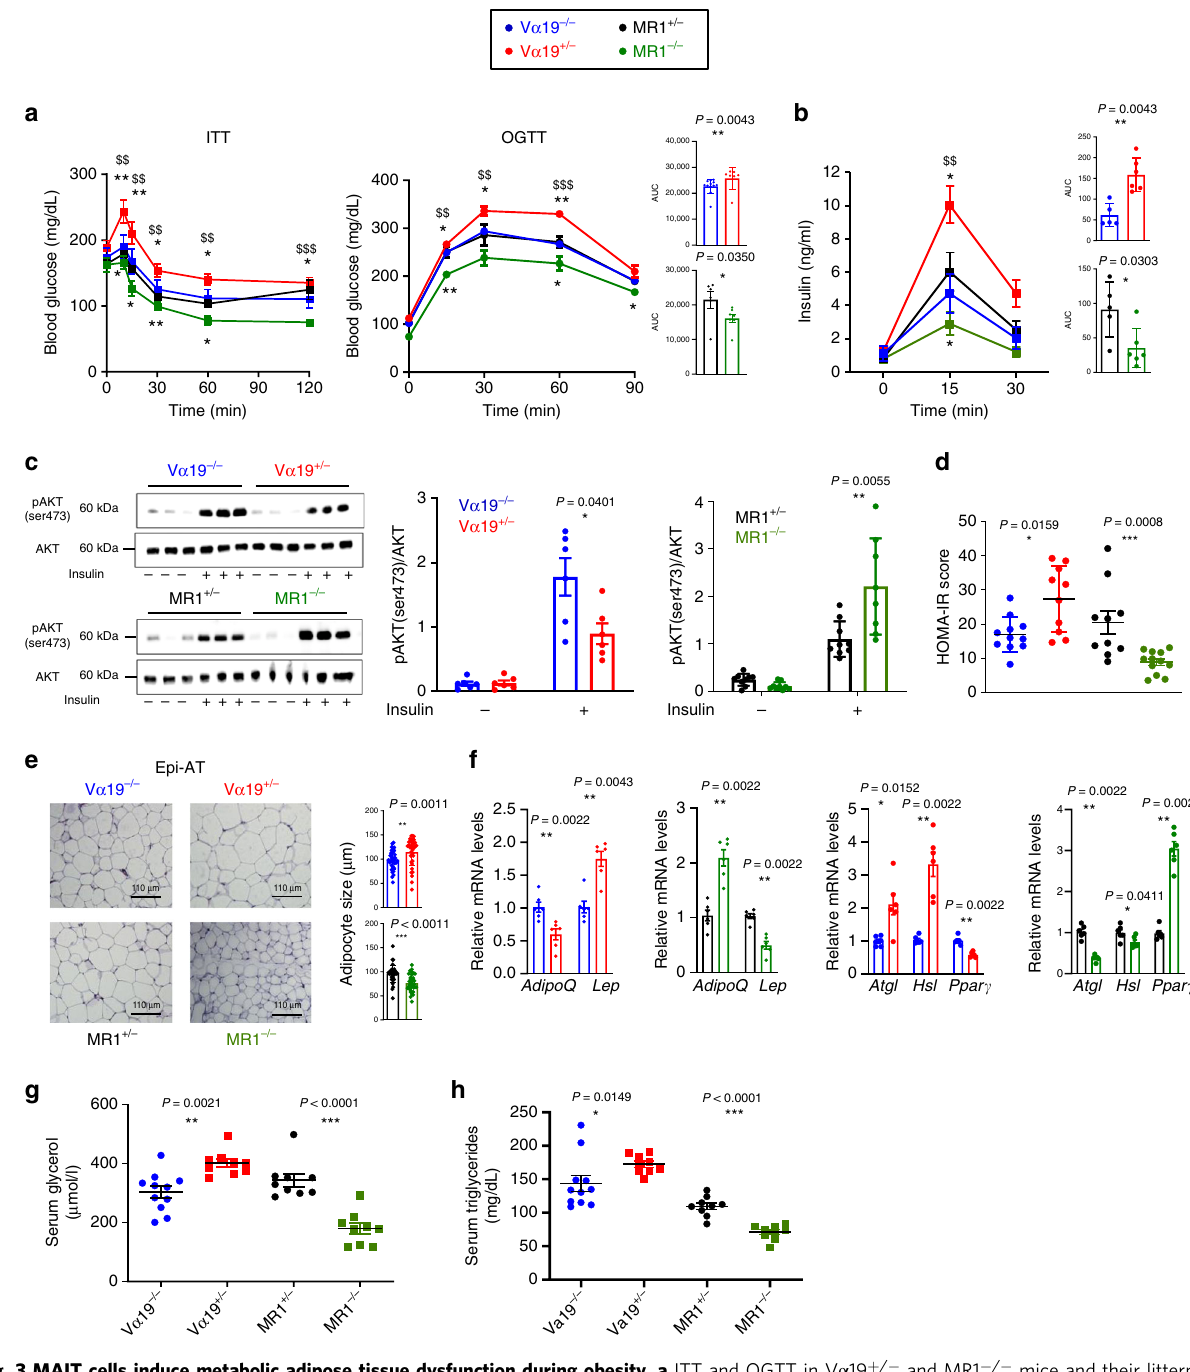
Fig. 3 MAIT cells induce metabolic adipose tissue dysfunction during obesity. a ITT and OGTT in V α 19 + / − and MR1 − / − mice and their littermate controls fed with HFD during 12 weeks (V α 19 − / − n = 12, V α 19 + / − n = 7, MR1 + / − n = 7, MR1 − / − n = 7). $ represents statistics between V α 19 + / − and MR1 − / − mice. Pooled data from two independent experiments are represented. b Plasma insulin during OGTT (V α 19 − / − n = 5, Va19 + / − n = 6, MR1 + / − n = 5, MR1 − / − n = 6). $ represents statistics between V α 19 + / − and MR1 − / − mice. Pooled data from two independent experiments are represented. c Western blot of three individual mice (left) and quanti fi cation (right) of AKT phosphorylation (p-AKT-S473) in Epi-AT from HFD-fed V α 19 + / − , MR1 − / − mice, and their littermate controls after insulin administration (2 UI/kg) in vivo (quanti fi cation n = 6 mice per group). d HOMA-IR index in V α 19 + / − ( n = 10) and MR1 − / − ( n = 12) mice, and their littermate controls (V α 19 − / − ( n = 11) and MR1 + / − ( n = 10)) fed with HFD during 12 weeks. Pooled data from two independent experiments are represented. e Representative hematoxylin & eosin staining of Epi-AT (V α 19 − / − n = 5, Va19 + / − n = 6, MR1 + / − n = 5, MR1 − / − n = 5). Scale bars, 110 μ m. Quanti fi cation of adipocyte size in Epi-AT of V α 19 + / − and MR1 − / − HFD-fed mice, and their littermate controls. f Graphs showing the relative quantity of adiponectin , leptin, Atgl , Hsl , and Ppar γ transcripts in Epi-AT from V α 19 + / − and MR1 − / − mice and their littermate controls fed with HFD during 12 weeks ( n = 6 mice per group). g , h Serum glycerol and triglyceride concentrations in V α 19 + / − ( n = 9) and MR1 − / − ( n = 9) mice and their littermate controls (V α 19 − / − ( n = 11) and MR1 + / − ( n = 9) fed with HFD during 12 weeks. Pooled data from two independent experiments are represented. For d , g , and h , each symbol represents an individual mouse. All data are represented as mean ± S.E.M. All statistical analyses were performed by two-tailed Mann – Whitney test. * or $ P < 0.05 ** or $$ P < 0.01, *** or $$$ P < 0.001 (see also Supplementary Figs. 5,